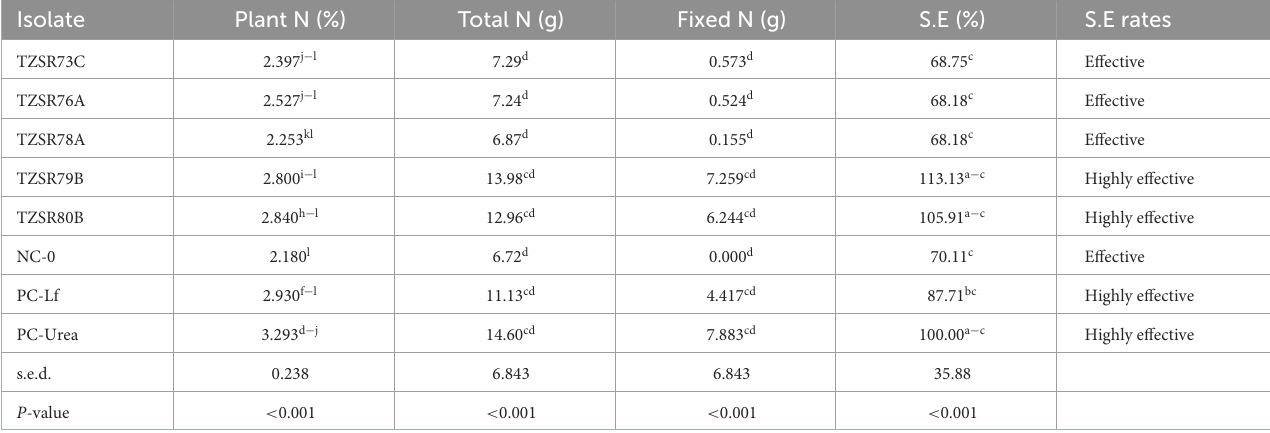
TABLE 4 Pearson correlation matrix for nodulation parameters (nodule number and dry weight), plant growth (root and shoot dry weight). Growth